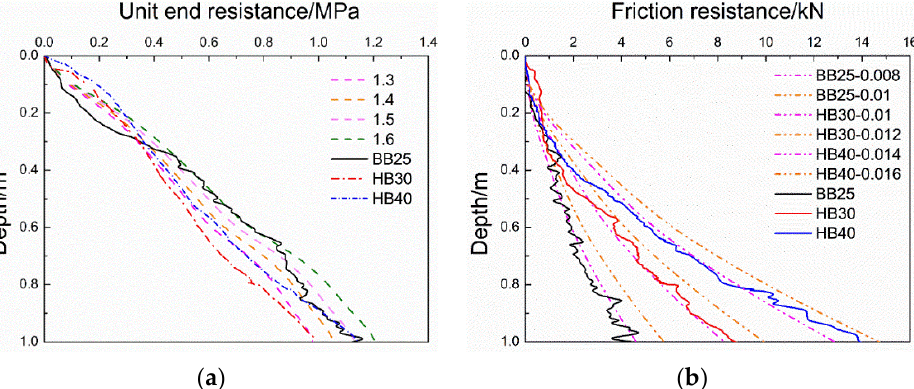
Figure 14. Coefficient values of the cone-penetration test: ( a ) the end coefficient- k friction coefficient- k f .